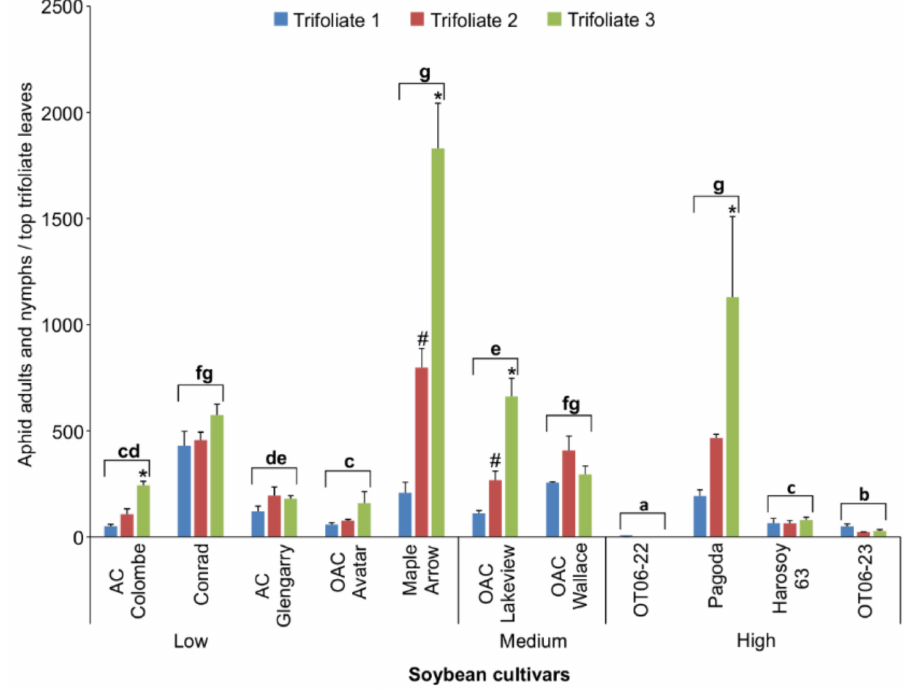
Figure 4. Mean aphid counts ( ± S.E.) on top 3 trifoliate leaves for 11 soybean cultivars after 4 weeks growth in the greenhouse. Bars with the same lowercase letters indicate no significant difference ( p > 0.05) for the average aphid counts between those cultivars. Bars with an asterisk (*) or hashtag (#) indicate a significant difference ( p < 0.05) between the number of aphids on the 1st and 3rd or 1st and 2nd trifoliate leaves,